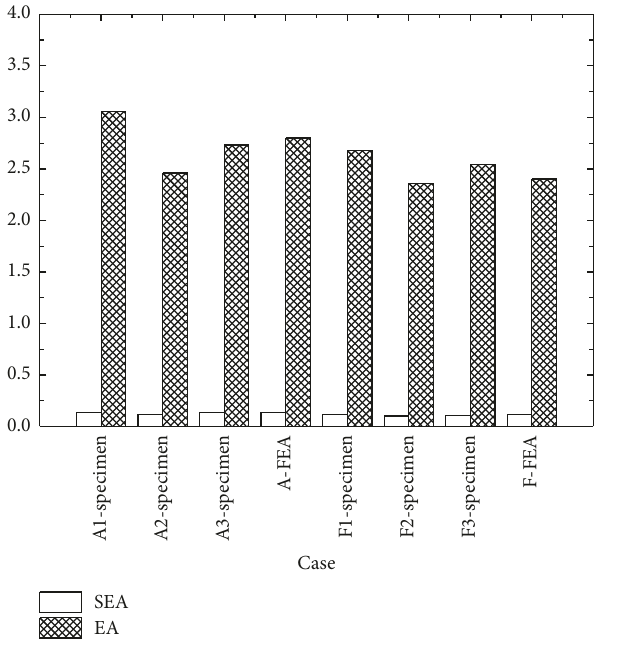
Figure 13: Comparison of different stacking sequence for speci- mens: EA and SEA.